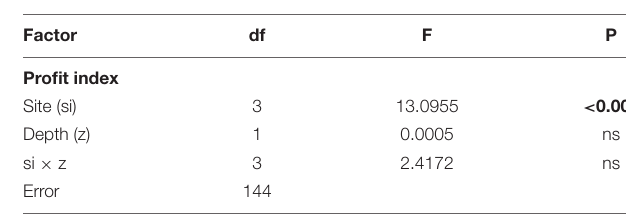
TABLE 5 | Results of ANOVA to determine the effect of cultivation site (si) and depth (z) on the new index PROFIT variability for the whole mussel cultivation